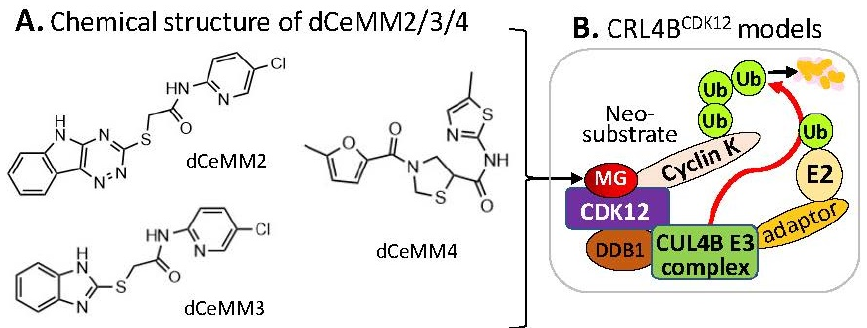
Figure 5. ( A ) The chemical structure of dCeMM2, dCeMM3, and dCeMM4 as MG compounds; ( B ) the substrate receptor-independent E3 ligase protein complex model for ubiquitination of the neosubstrate cyclin K. The MG compounds dCeMM2/3/4 shown in ( A ) was found through a substrate receptor-independent manner (neither CRBN nor DCAF15 being involved) to glue CDK12-cyclin K directly on DDB1–CUL4B E3 ligase complex to polyubiquitinate cyclin K. Then, the polyubiquitinated cyclin K would be degraded through the ubiquitination proteasome pathway.